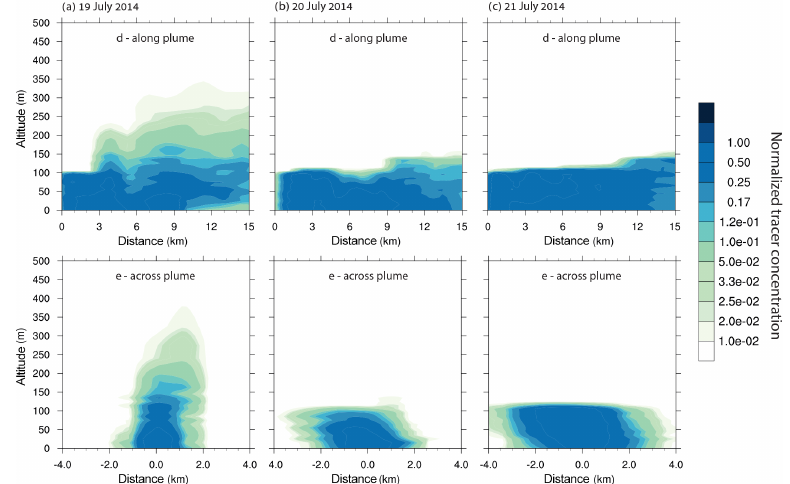
Figure 7. Vertical cross sections (normalized tracer concentrations) predicted by FLEXPART-WRF along plumes (panels marked d – along plume) and across plumes (panels marked e – across plume) for the same times as shown in Fig. 5.